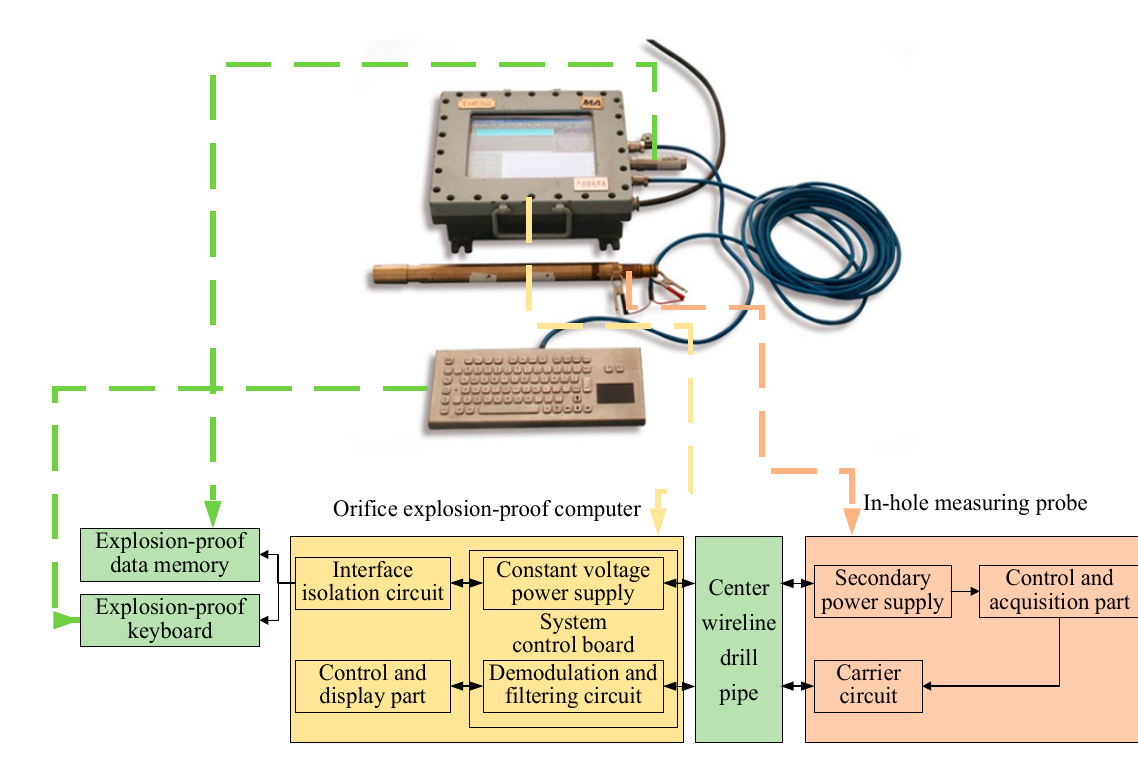
Figure 5. Composition of YHD2-1000 (A) Mine Wired MWD System.